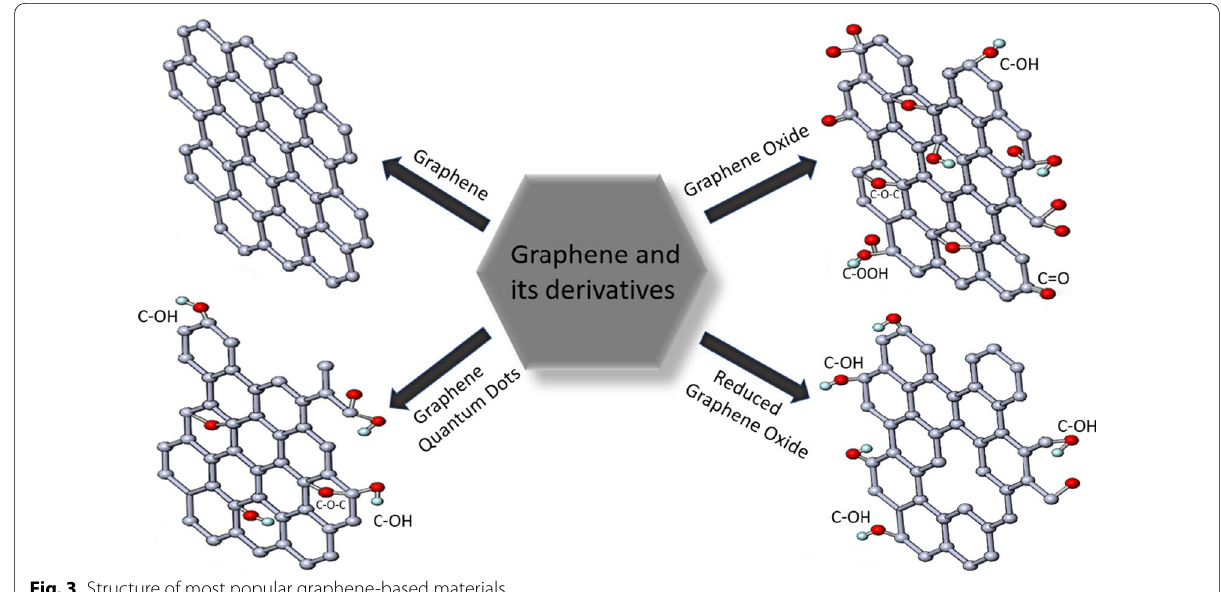
Fig. 3 Structure of most popular graphene-based materials